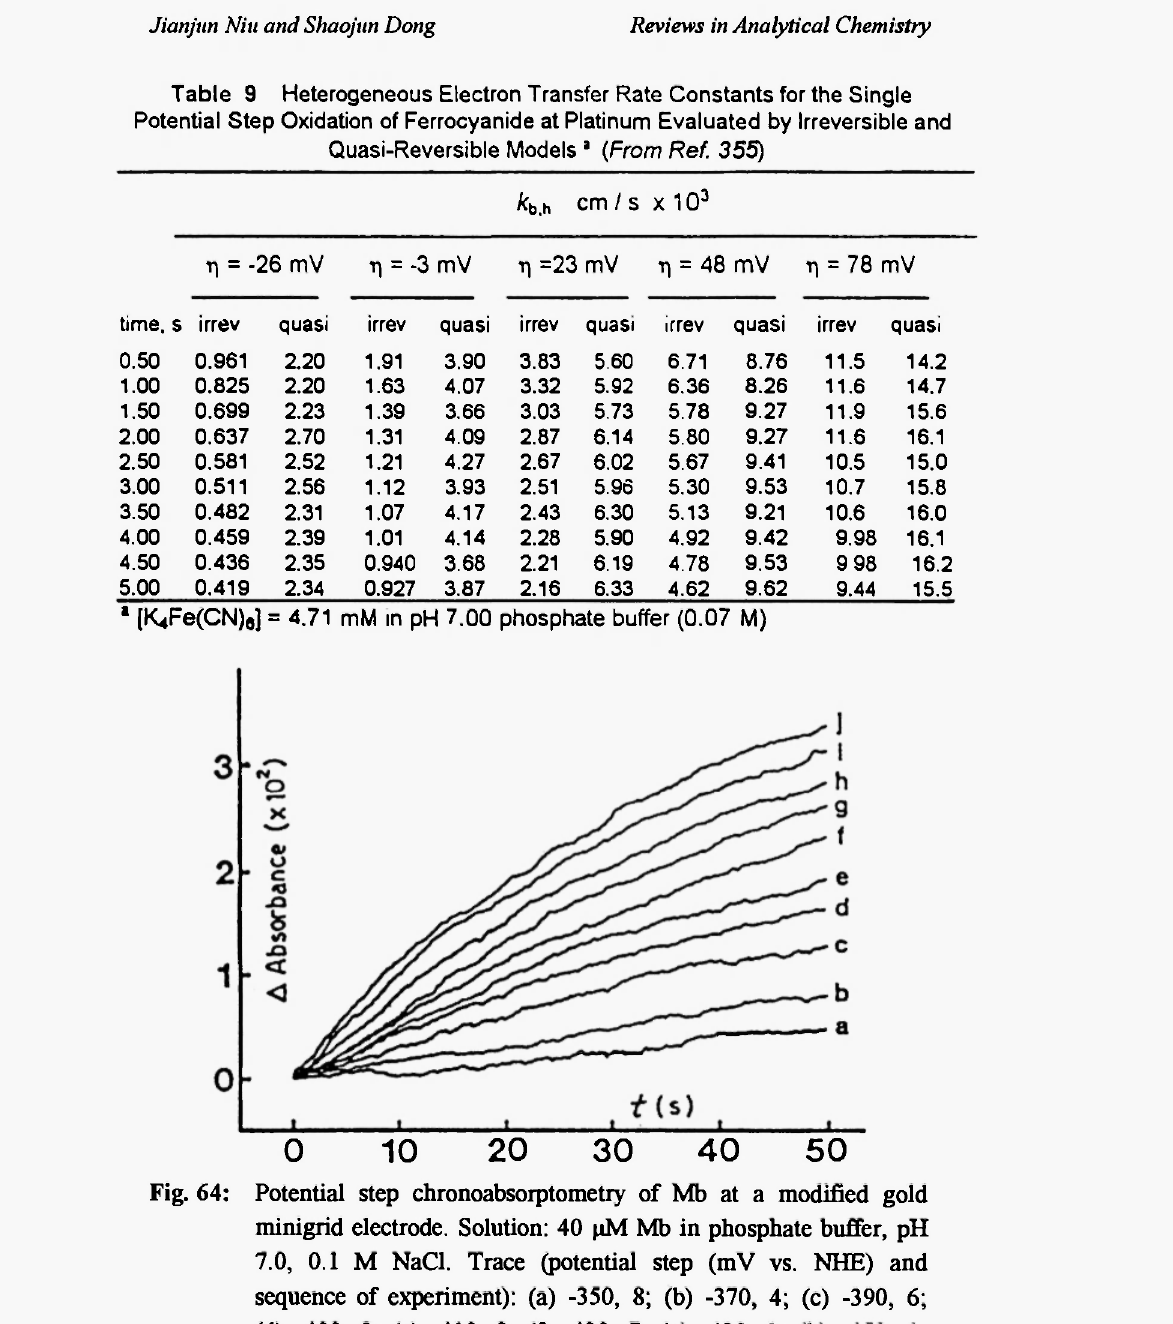
Potential step chronoabsorptometry of Mb at a modified gold minigrid electrode. Solution: 40 μΜ Mb in phosphate buffer, pH 7.0, 0.1 Μ NaCl. Trace (potential step (mV vs. NHE) and sequence of experiment): (a) -350, 8; (b) -370, 4; (c) -390,